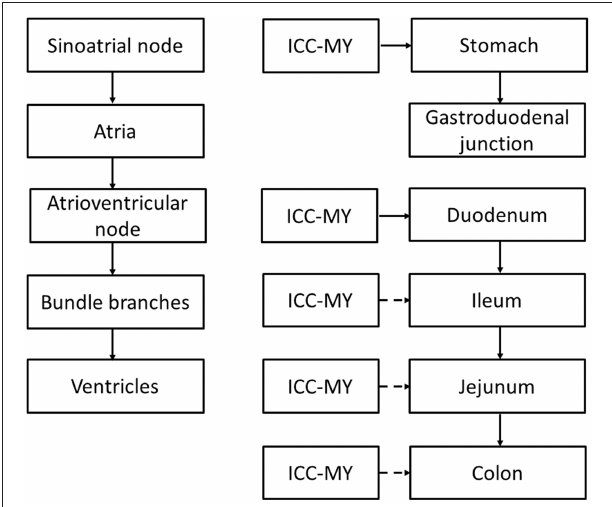
FIGURE 1 | Comparison between the cardiac and gastrointestinal conduction pathways. ICC-MY: interstitial cells of Cajal in the myenteric plexus, pacemaker cells of the GI tract. Broken arrows indicate that the ICC is normally reset by the dominant pacemaker upstream that has the highest rate of